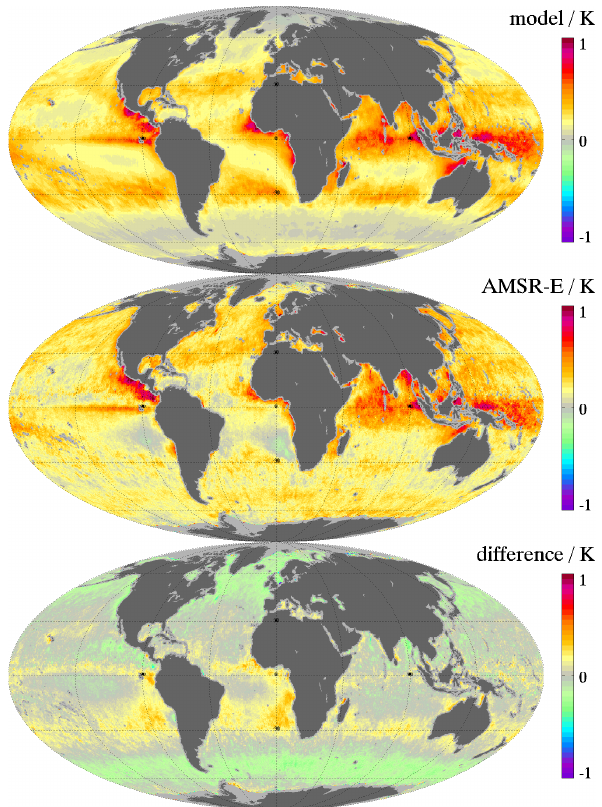
Fig. 8. Day-night difference in SST at AMSR-E locations and times, averaged over June 2006–May 2007. Top: model results, centre: AMSR-E observations, bottom: model minus